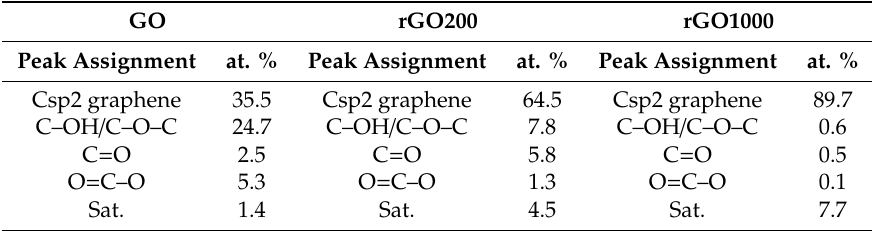
Table 2. Assignments of C1s XPS peaks for GO, rGO200 and rGO1000. Csp 2 : sp 2 carbon; Sat.: shake-up satellites ( π to π * transitions).